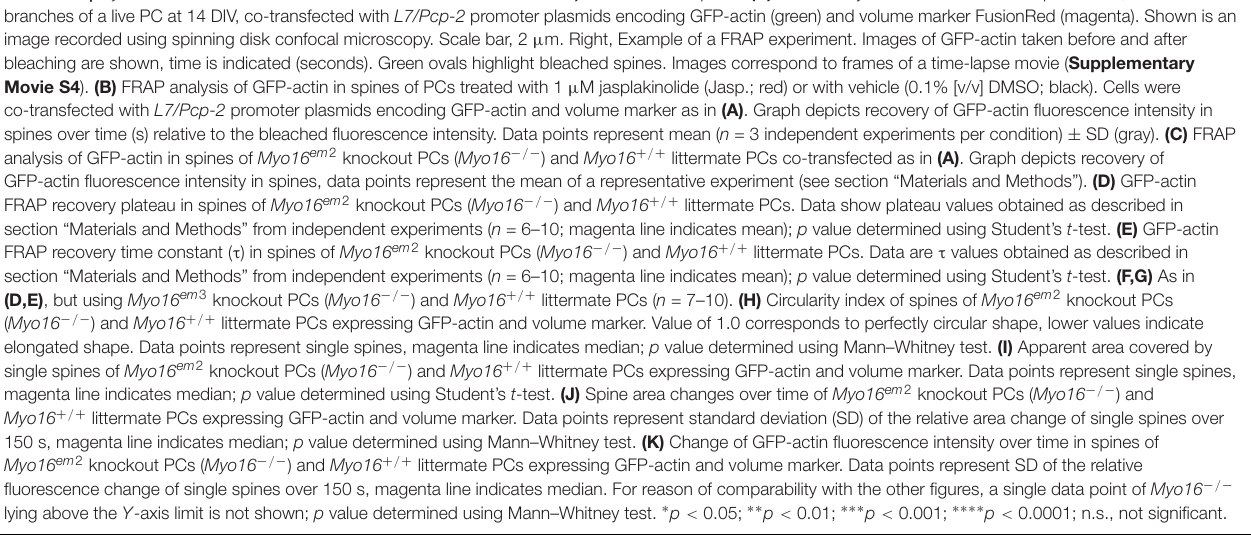
Frontiers in Cellular Neuroscience |